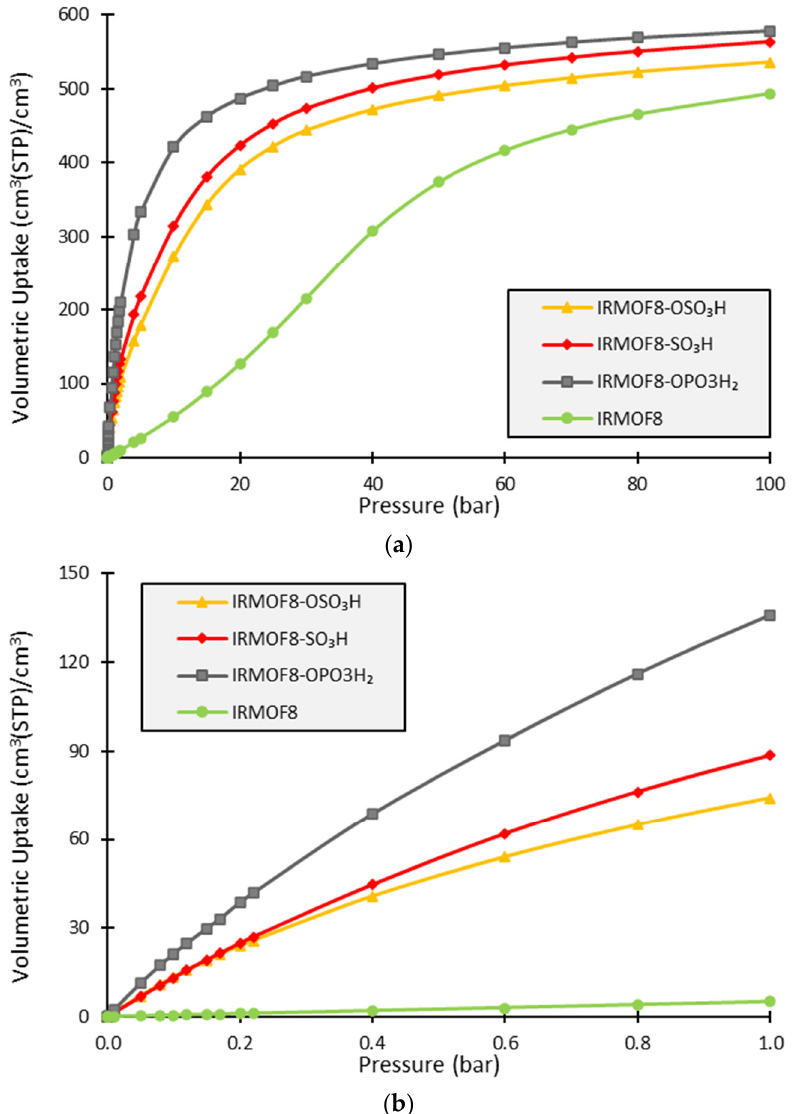
Figure 7. Absolute volumetric isotherms for IRMOF8 and IRMOF8-n (n: -OSO 3 H, -SO 3 H, and -OPO 3 H 2 ,) at T = 298 K and pressure ranges up to ( a ) 100 bar ( b ) 0.10 bar.